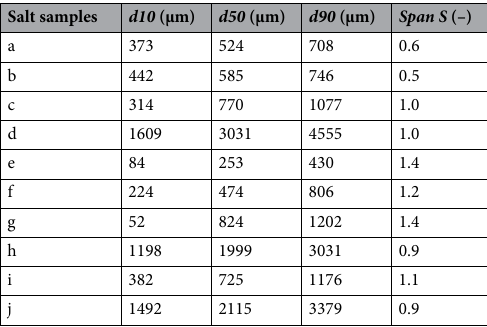
Table 3. Particle size distribution of salt samples.